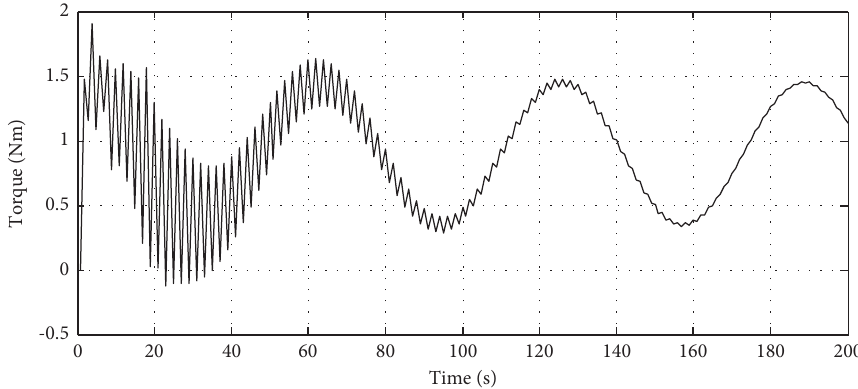
Figure 13: PMSM torque in the mode of doubling the